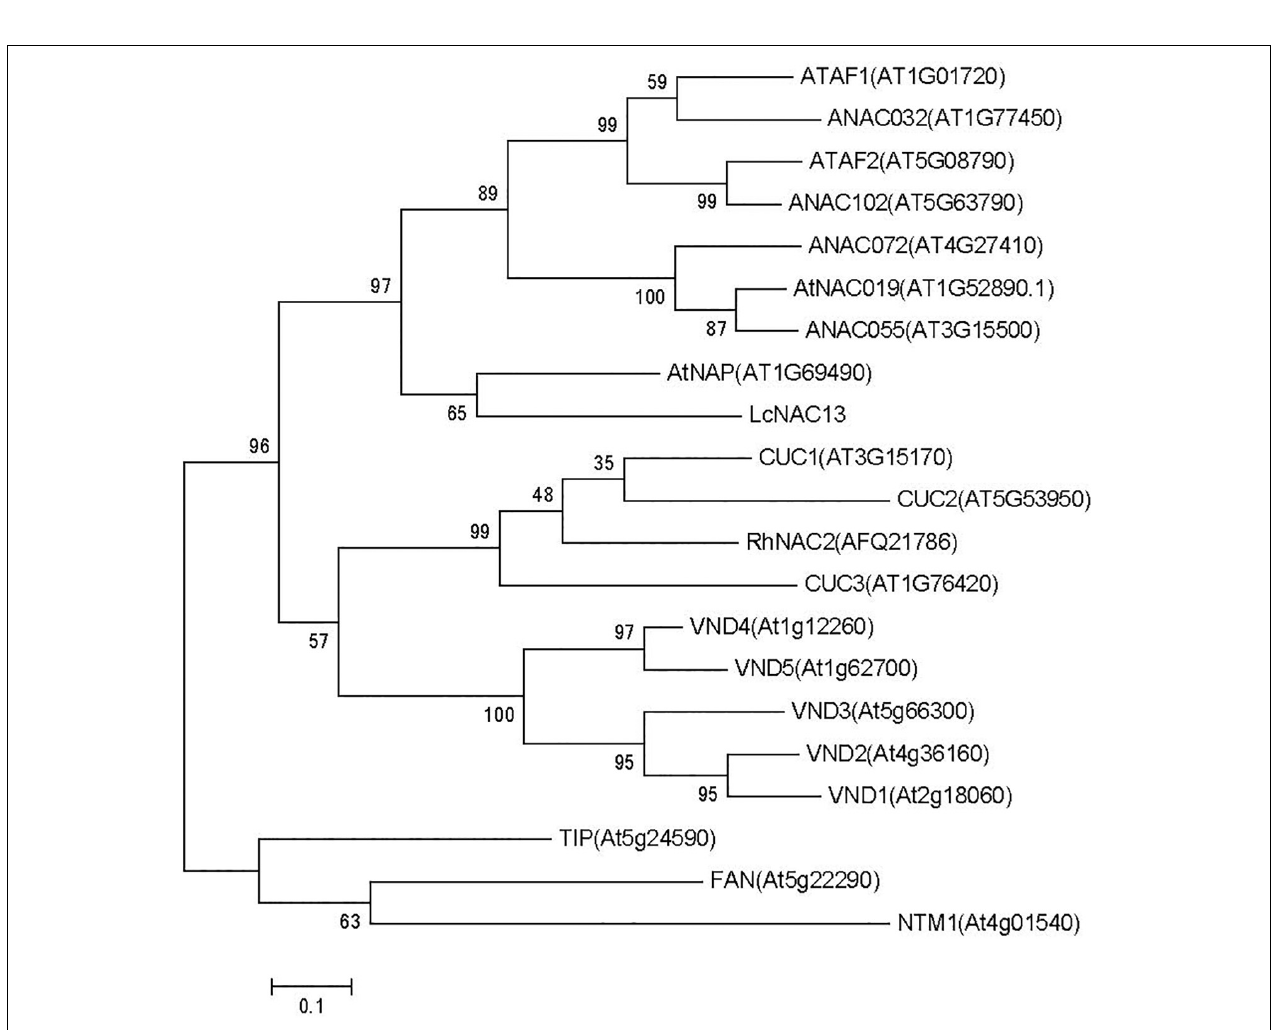
FIGURE 4 | Phylogenetic tree analysis of NAC. From the results of the evolutionary tree analysis, the most similar one to LcNAC13 is AtNAP. A phylogenetic tree was constructed by neighbor-joining (NJ) method using MEGA 6.0 program.